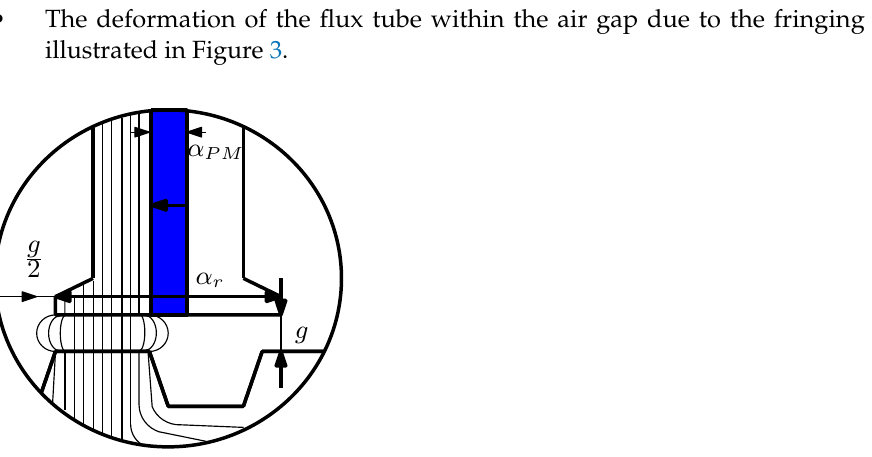
Figure 3. Flux tube deformation within the air gap: the fringing